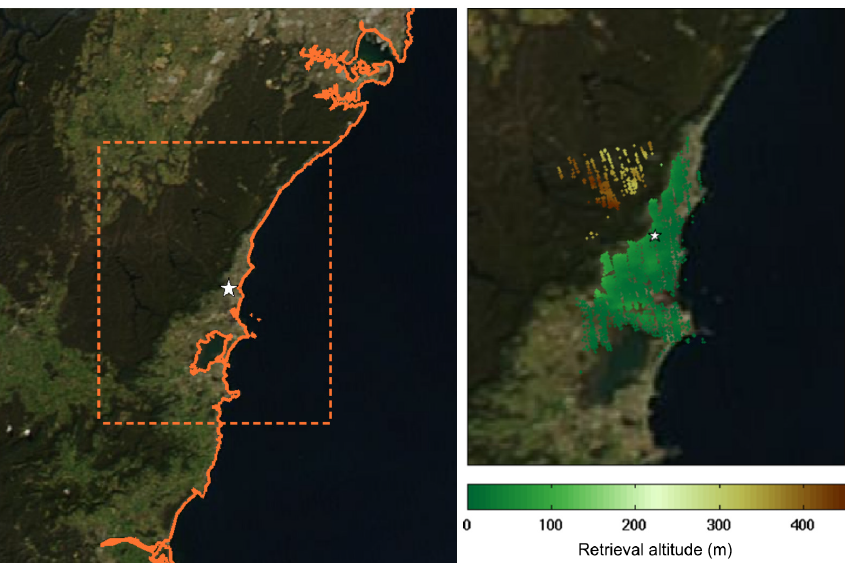
Figure 8. The left panel shows the MODIS true-color image of the Wollongong region. The orange solid line marks the east coast of Australia; the South Pacific (Tasman Sea) lies to the east. The sharp Illawarra escarpment is the dark region inland, mostly contained in the dashed orange box. The dashed orange box shows the latitude and longitude extent of the images in the right panel and in Fig. 9, and the white star indicates the location of the Wollongong TCCON station. The right panel shows the retrieval altitudes near the Wollongong TCCON station (indicated by the white star) compiled from several target maneuvers.